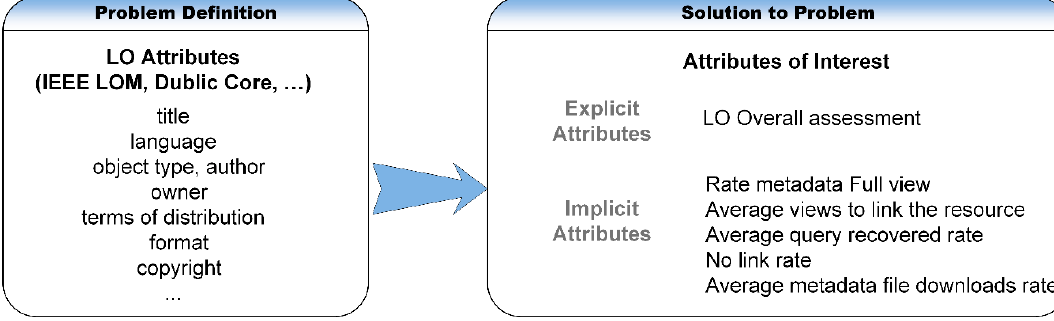
Figure 12. Example of representation of cases in the LO domain.